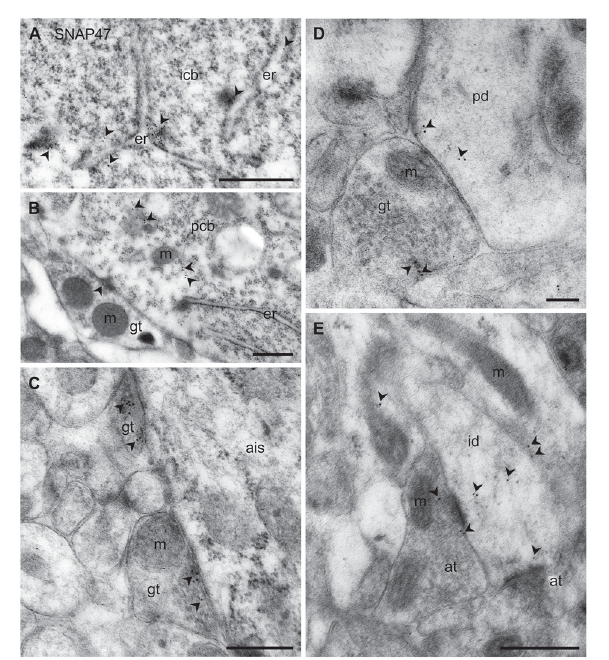
FIGURE 11 | Ultrastructural localization of SNAP47 in axon terminals and dendrites of GABAergic INs of the mouse hippocampus. (A) Postembedding immunogold labeling for SNAP47 (10 nm gold, arrowheads) in the cytoplasm of a putative interneuron cell body (icb) in the CA3 stratum radiatum associated to the endoplasmic reticulum (ER). Scale bar: 500 nm. (B) A putative GABAergic basket cell terminal (GABAergic terminals, gt) forming symmetric contact onto a pyramidal cell body (pcb) in the CA3 stratum pyramidale . Note that postembedding immunogold labeling for SNAP47 (10 nm gold; arrowheads) was preferentially found postsynaptically in the pyramidal cell body and only at lower level presynaptically in the inhibitory axon terminals. Scale bar: 200 nm. (C) Putative gt making symmetric contacts with the axon initial segment (AIS) of a pyramidal cell in the CA3 region. Arrowheads indicate immunogold labeling for SNAP47 (10 nm gold) found at low level in the axon terminals. Scale bar: 500 nm. (D) Putative gt making symmetric contact with a dendritic shaft (pd) of a putative pyramidal cell in the CA3 region. Arrowheads indicate immunogold labeling (10 nm gold) for SNAP47 found in pyramidal dendritic shaft and at low level in the axon terminal. Scale bar: 200 nm. (E) A putative interneuron dendritic shaft (id) receiving convergent asymmetrical, presumably excitatory synapses with small axon terminals (at) in the CA1 stratum radiatum . Arrowheads indicate immunogold labeling (10 nm gold) for SNAP47 found in the dendritic shaft and in the axon terminal. Scale bar: 500